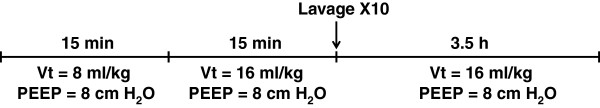
Experimental procedures for a rat model of ARDS.